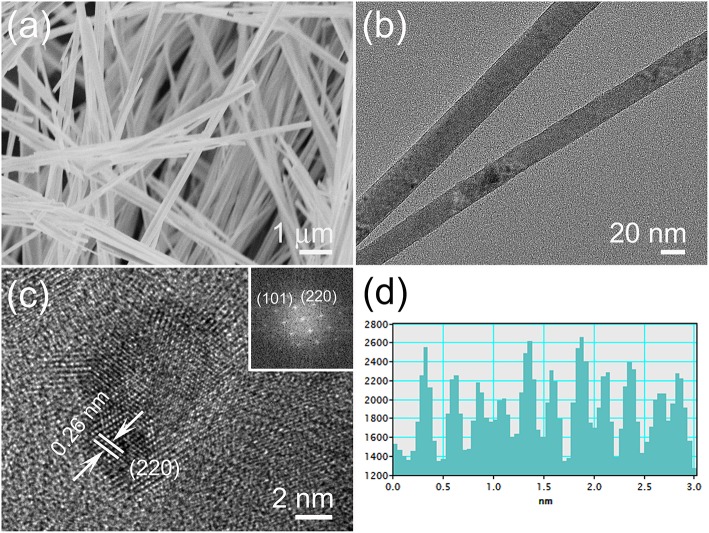
(a) SEM, (b) TEM, and (c) HR-TEM images of the one-dimensional V0.13Mo0.87O2.935 nanowires; the illustration shows the FFT pattern and (d) the corresponding lattice spacing obtained from (c).